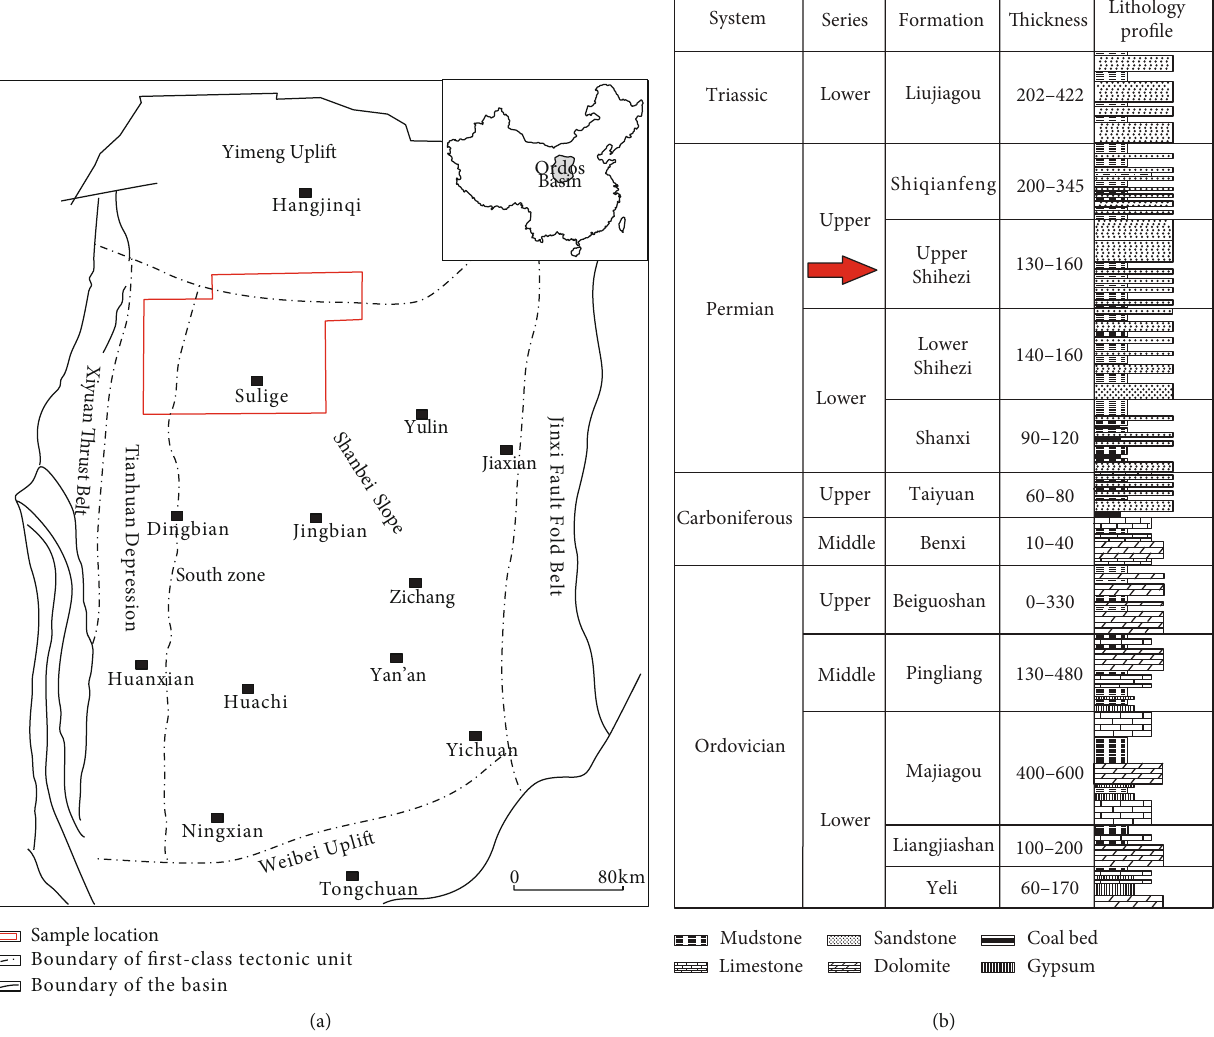
Figure 1: (a) Locations of the Ordos Basin and the tectonic divisions of the Ordos Basin and (b) comprehensive Ordovician Majiagou- Triassic Liujiagou stratigraphic column of the Ordos Basin [2, 4, 27,